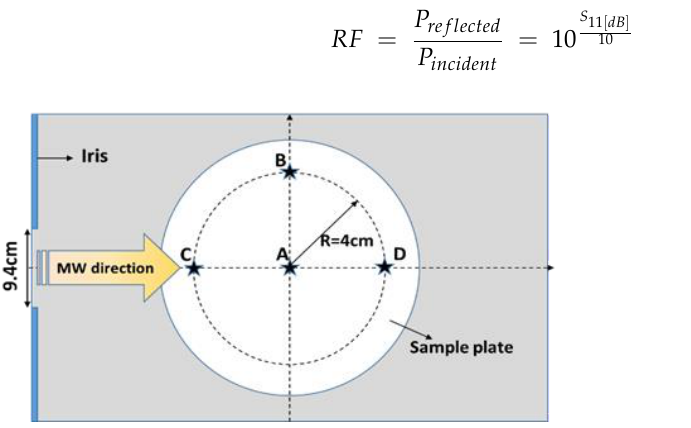
Figure 2. Sample positions within the single-mode microwave cavity (view from the top of the microwave cavity).